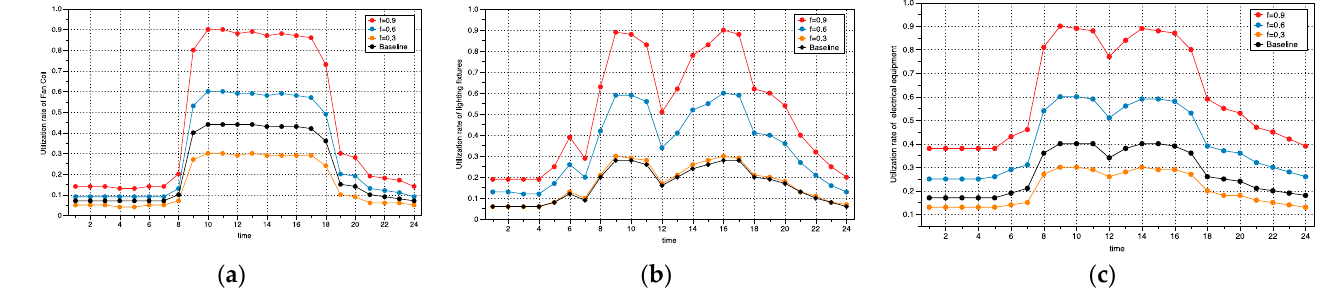
Figure 9. Runtime schedule expansion: ( a ) HVAC system utilization; ( b ) Lighting utilization; ( c ) Device utilization.